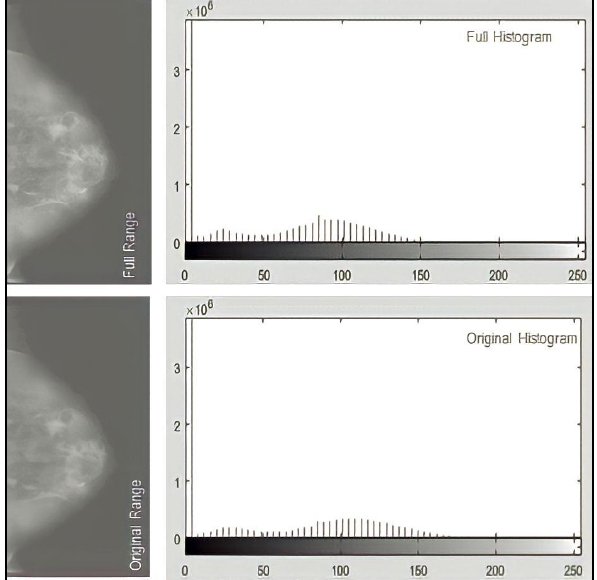
Figure 7. Ranges available in the CLAHE function and their histograms.